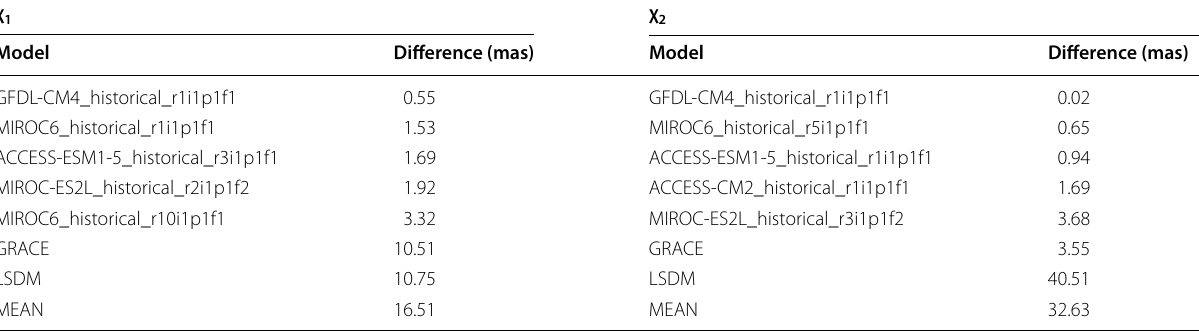
Table 6 Absolute values of differences of non-seasonal variance in χ models with the smallest differences are